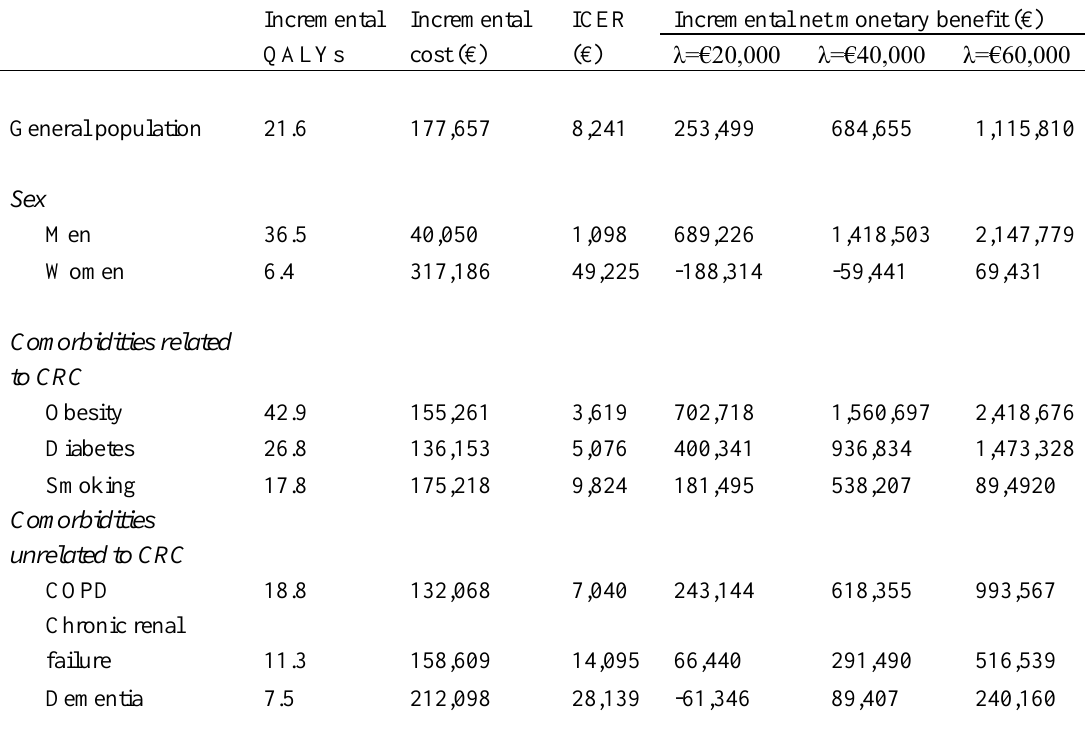
λ= monetary value of a quality -adjusted life year gained. COPD: chronic obstructive pulmonary disease, CRC: colorectal